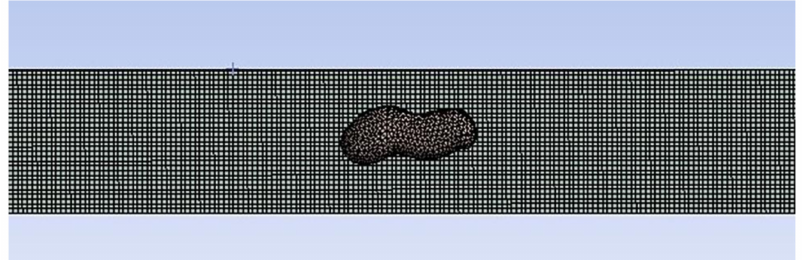
Figure 8. Drawing grid with the simulation model.